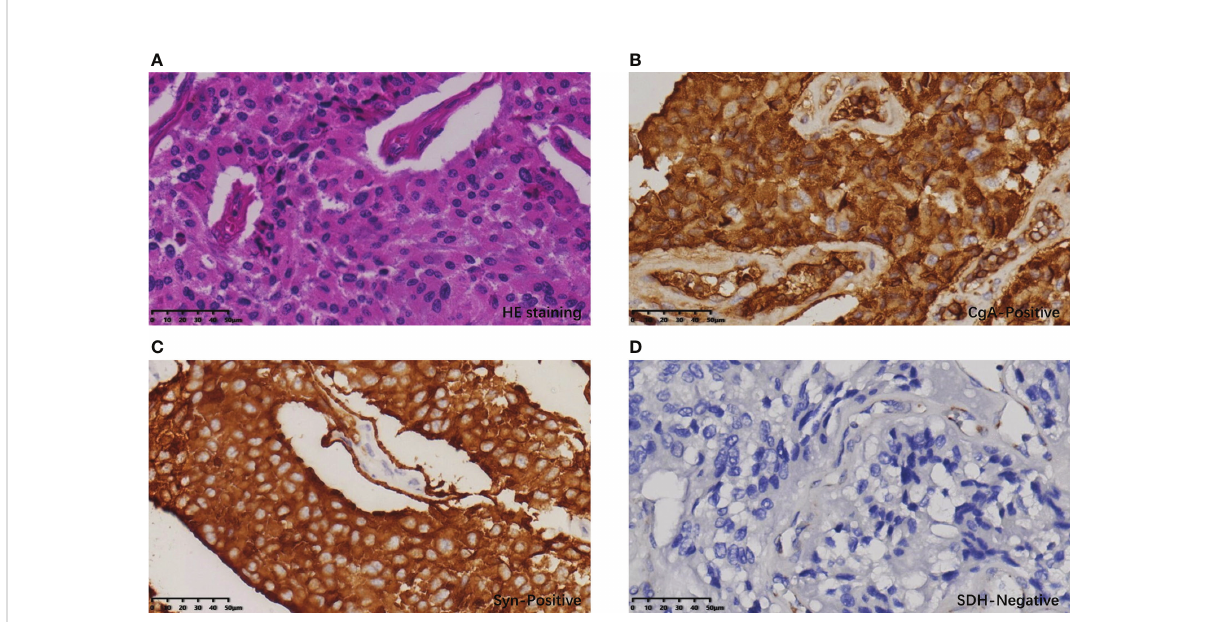
FIGURE 4 Histopathological and immunohistochemical results of PGL: (A) The cells of the bladder tumor were arranged in nests under HE staining, with abundant cytoplasm and stroma rich in thin-walled blood vessels. (B) Tumor cells showed diffuse CgA positivity. (C) Tumor cells showed diffuse Syn positivity. (D) Tumor cells showed diffuse SDH negativity; vascular endothelial cells served as an SDH positive